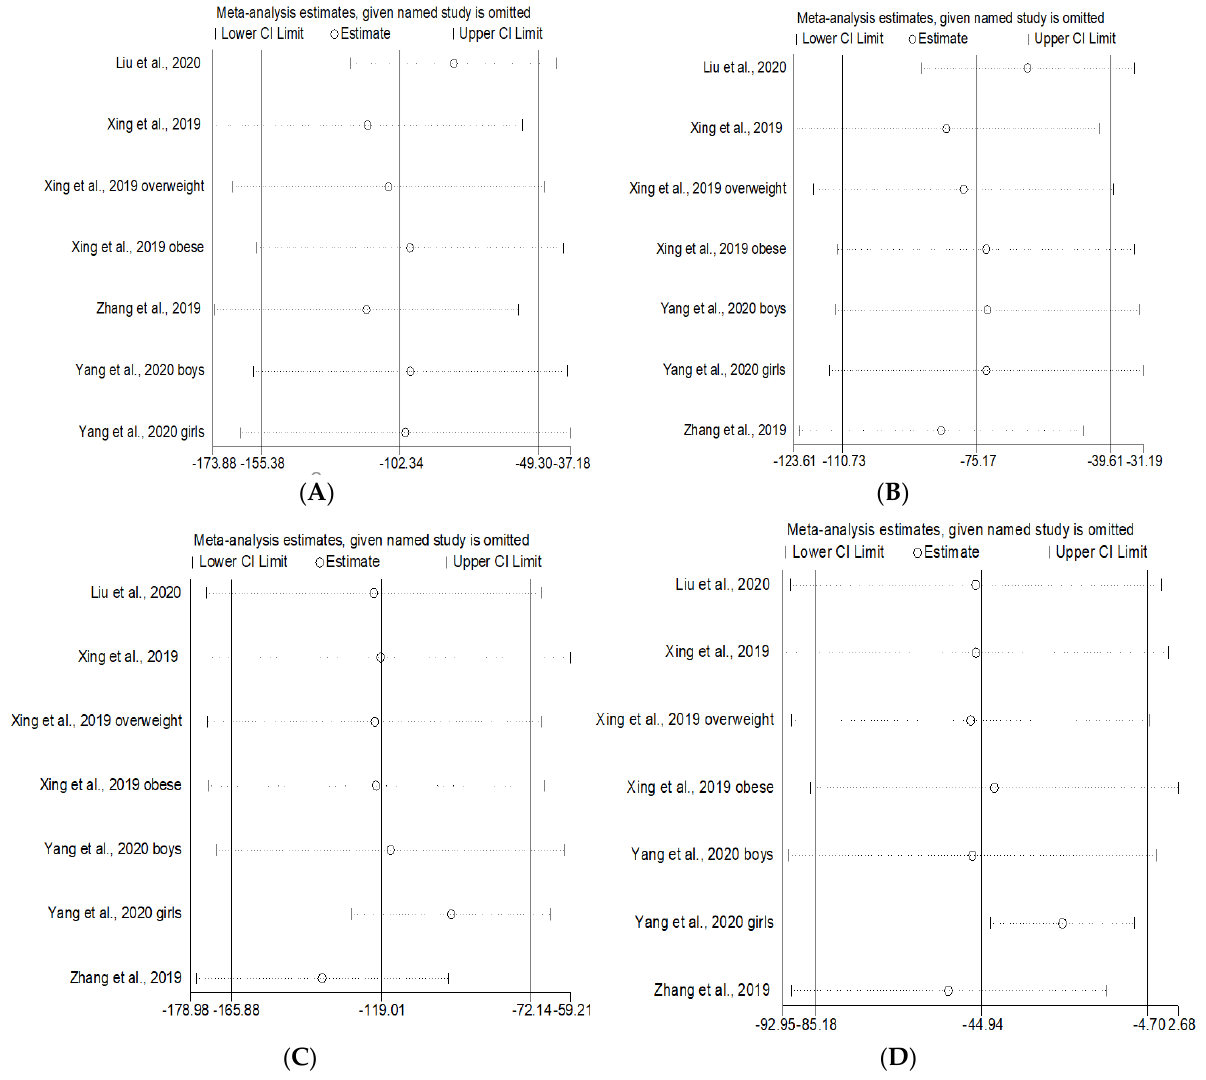
Figure 7. Sensitivity analyses of included studies in the long-term exposure group: ( A ) FVC, ( B ) FEV 1 , ( C ) PEF, ( D ) MMEF [30,33 – 35].